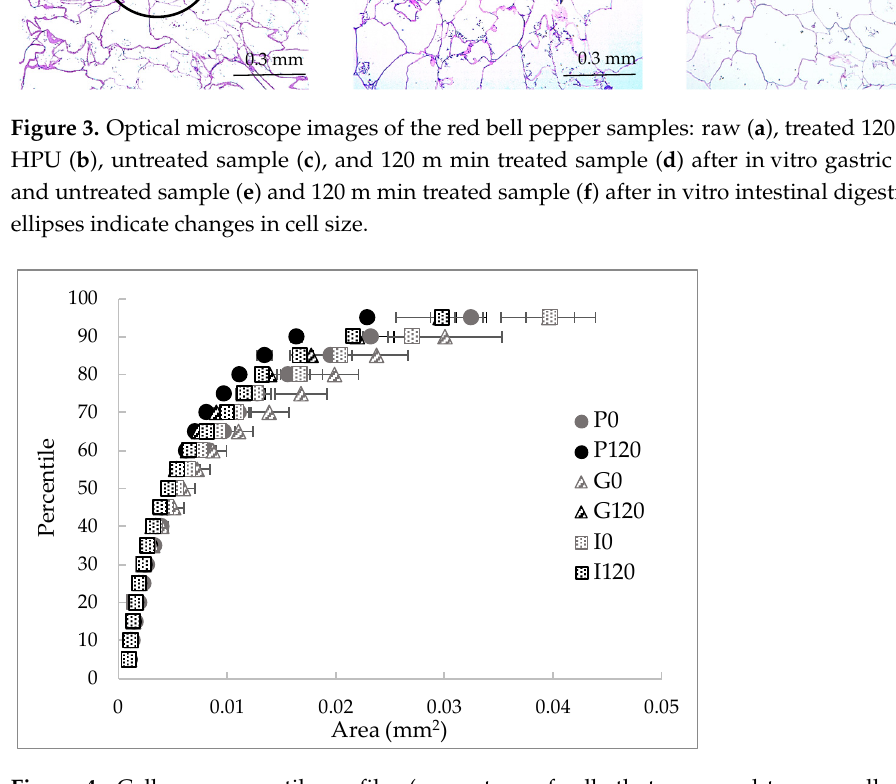
Figure 4. Cell area percentile profiles (percentage of cells that are equal to or smaller than the corresponding area) of the red bell pepper samples: raw (P0), treated 120 min with HPU (P120), and these samples after in vitro gastric (G) and intestinal (I) digestions.